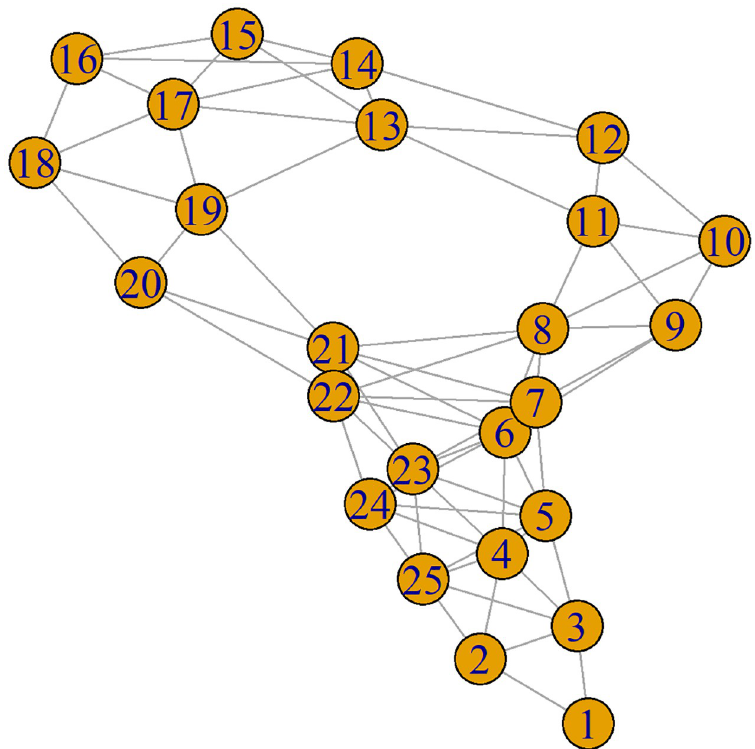
obtained from the immuno dataset using the outlined adjacency 25